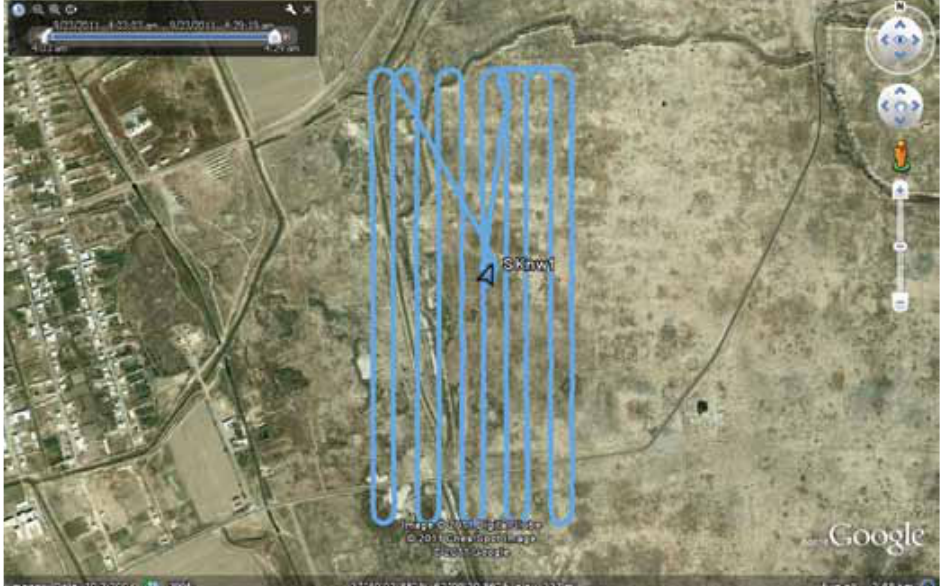
Fig. 9: Tracklog of a single flight in the north-west of Sultan Kala (output as a kml file from the software and displayed on the Google Earth satellite image). The UAV took off north-west from near the centre of the survey area, before starting the systematic north-south runs pre-programmed in the flight